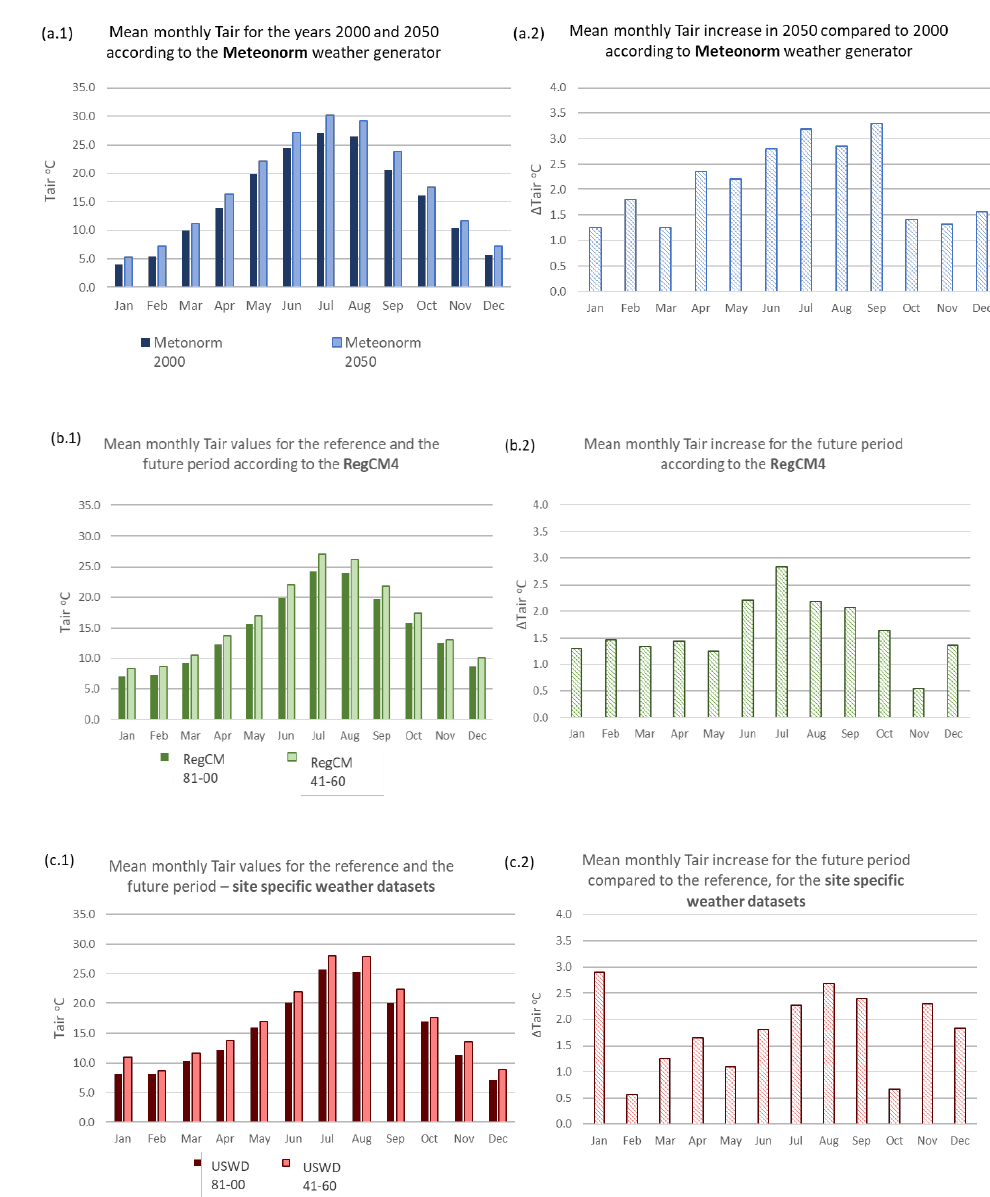
Figure 9. Estimated mean monthly Tair values for the present day (reference), the future period 2041–2060 and the respective Tair increase for ( a ) the Meteonorm-generated weather datasets, ( b ) the datasets created from the RegCM4 output and ( c ) the USWDs, based on the RegCM4 output and the ENVI-met microclimate simulations.